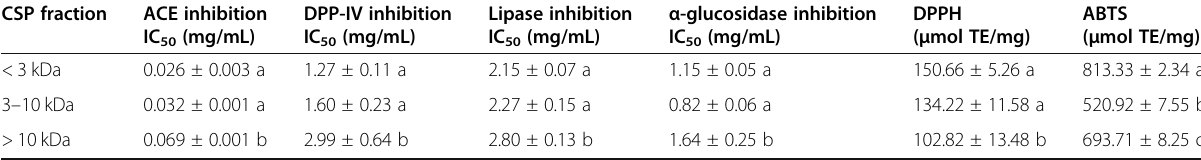
Values represent mean ± standard deviation of triplicate determinations. Different letters (a – c) within columns indicate significant difference ( p <0.05) between canary seed peptide (CSP)